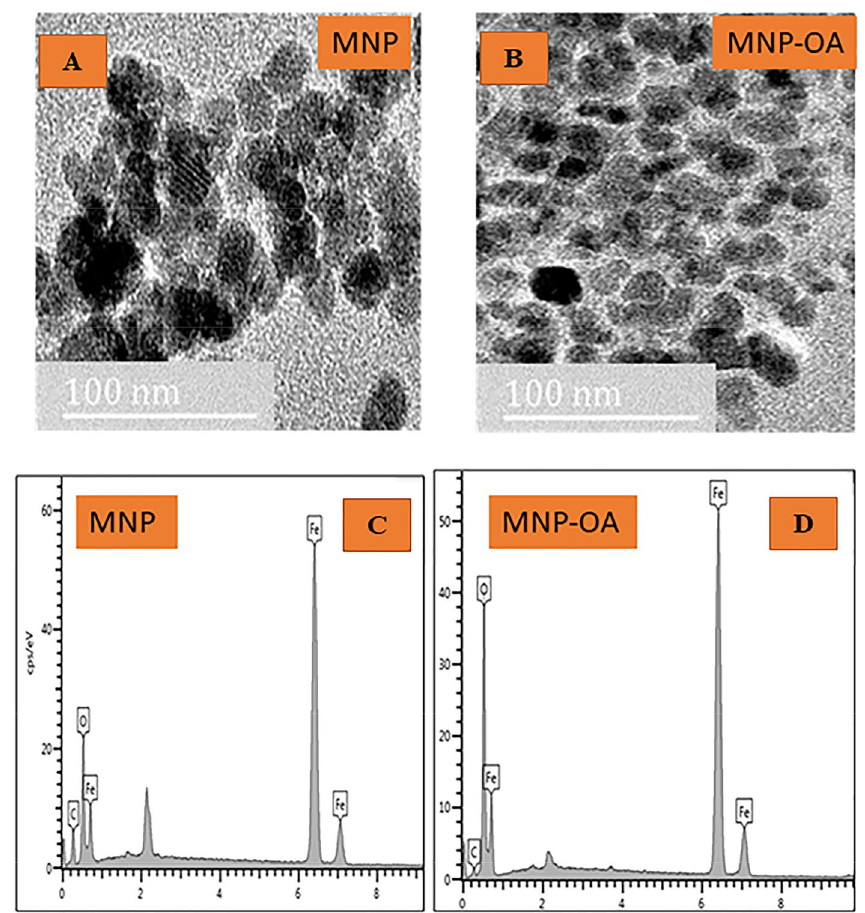
Figure 7. TEM images and EDX of pure MNP ( A , C ), and MNP-OA ( B , D ) composite.